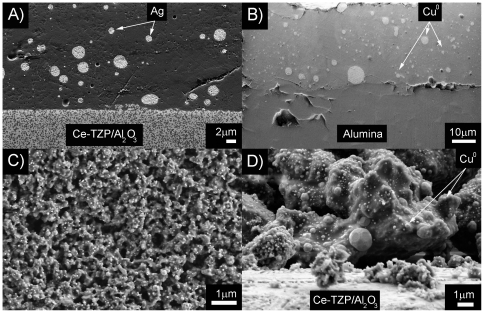
Scanning electron micrographs corresponding to: A) cross-section of n-Ag glass coating on Ce-TZP/nAl2O3 substrate sintered at 740°C, 1 h in air atmosphere; B) cross-section of n-Cu glass coating on alumina substrate sintered at 1150°C, 1 h in argon atmosphere; C) top view and D) cross-section of n-Cu glass coating on Ce-TZP/nAl2O3 substrate sintered at 850°C, 1 h in argon atmosphere.